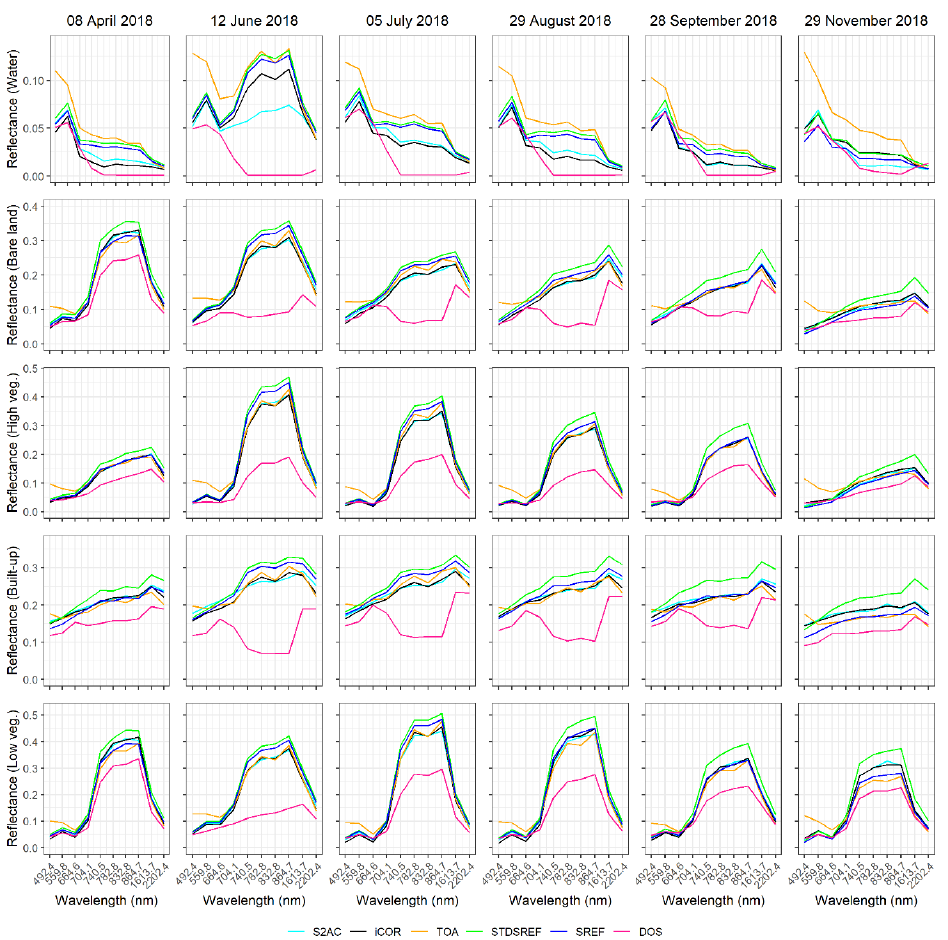
Figure 4. Sentinel-2 spectral signatures of five atmospheric corrections and TOA on five land cover classes for the year 2018.